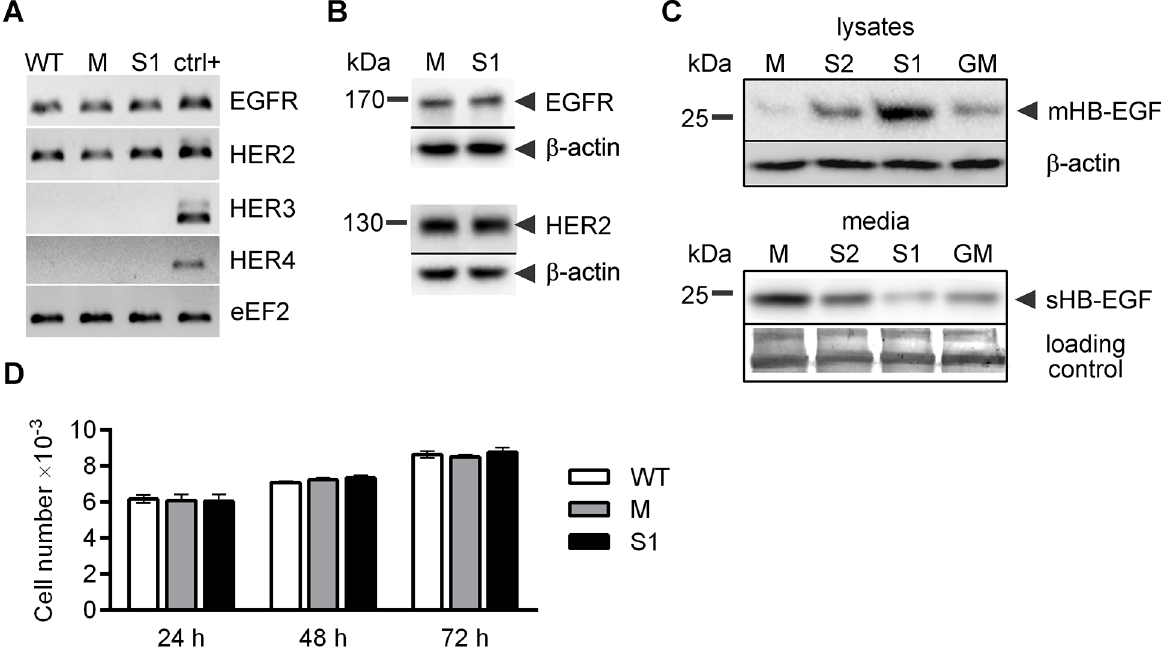
Fig 2. Analysis of the effect of ADAM17 silencing on lymphatic endothelial cells (LEC) proliferation. ( A ) RT-PCR analysis of the expression of members of the EGF receptor family in wild type (WT), M and S1. Positive control (ctrl+) – cDNA from cells that express particular receptors. Reaction mixtures after 40 cycles of quantitative RT-PCR were subjected to electrophoresis in the presence of ethidium bromide (EtBr). The result (shown in photographic negative) is representative of 3 performed experiments. ( B ) Western blotting analysis of EGFR and HER2 in LEC lysates. ( C ) Western blotting analysis of HB-EGF in cell lysates and media of LEC sublines M, S1, S2 and of M exposed for 48 h to 25 μ M GM6001 (GM). mHB-EGF, membrane HB-EGF; sHB-EGF, soluble HB-EGF. ( B, C ) β -actin was used as a loading control of lysate proteins; a fragment of blot stained with Coomassie Brilliant Blue after antigen detection procedure was used as a loading control of media proteins. Representative pictures of three independent experiments are shown. ( D ) Changes in the number of WT, M and S1 cultured in basal medium acquired by cell counting. Bars represent mean ± SD of three independent experiments performed in